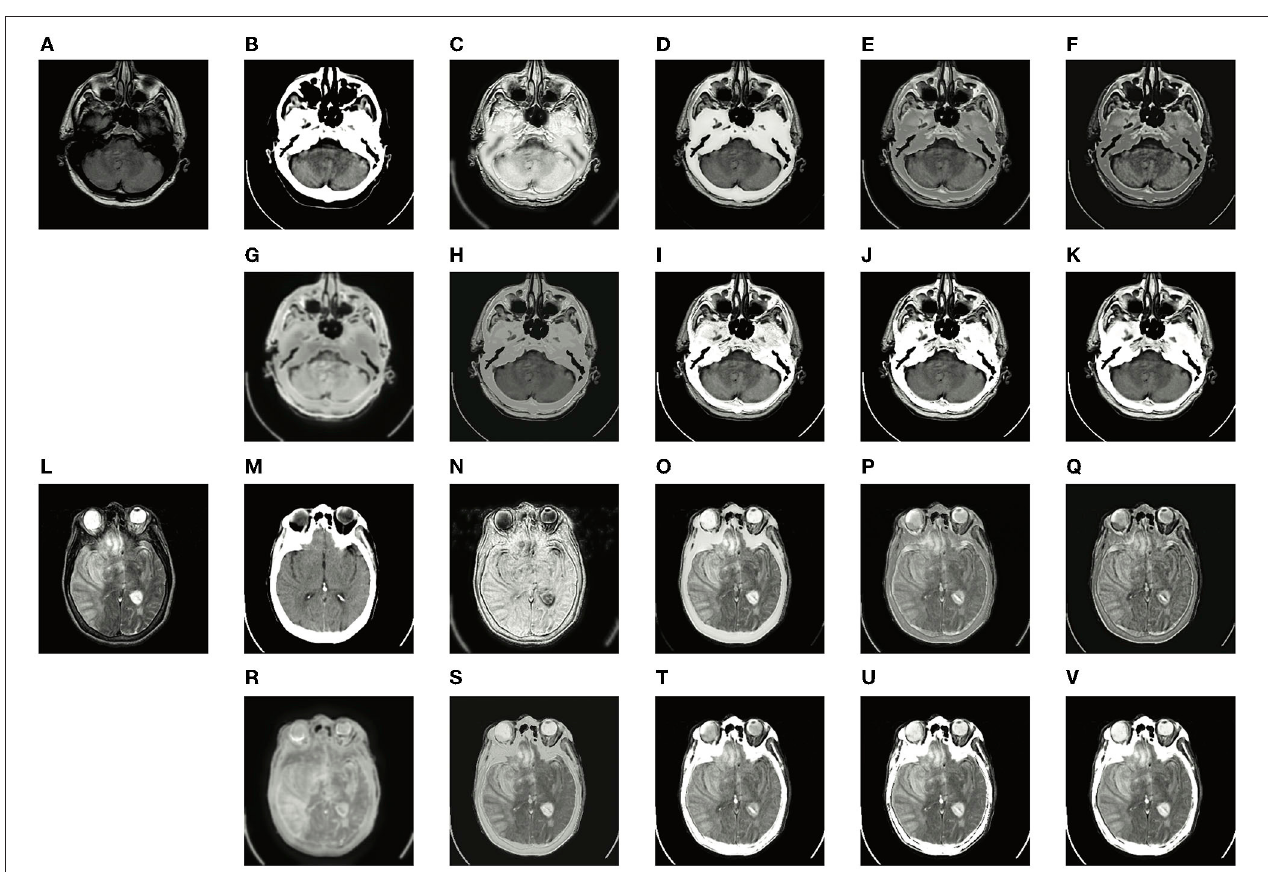
FIGURE 4 | Experiments results of the proposed method with six deep learning-based methods on two typical MRI and CT image pairs. (A,L) MRI images; (B,M) CT images; (C,N) fused results of DDcGAN; (D,O) fused results of EMFusion; (E,P) fused results of IFSR; (F,Q) fused results of U2Fusion; (G,R) fused results of DRF; (H,S) fused results of SEDR; (I,T) fused results of proposed-add; (J,U) fused results of proposed-max; and (K,V) fused results of proposed-l1.